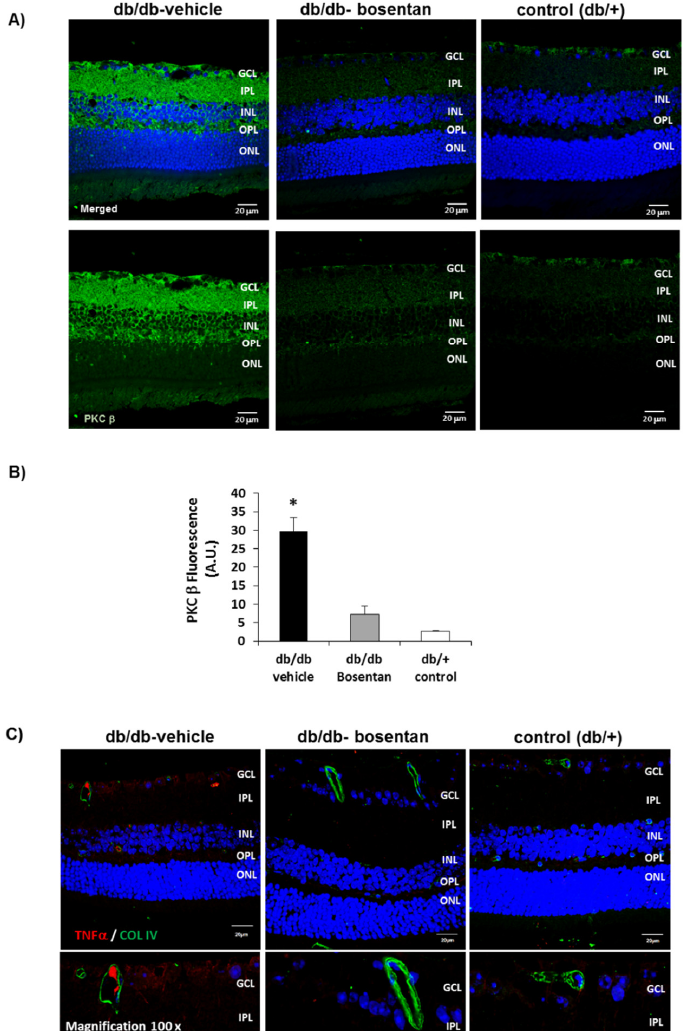
Figure 5. ( A ) Comparison of PKC β immunofluorescence (green) between representative samples from a db/db mouse treated with vehicle, a db/db mouse treated with bosentan, and a non-diabetic mouse (db/+). Nuclei were labeled with Hoechst (blue). Scale bar: 20 µm. GCL: Ganglion cell layer; IPL: Inner plexiform layer; INL: Inner cell layer; OPL: Outer plexiform layer; ONL: Outer